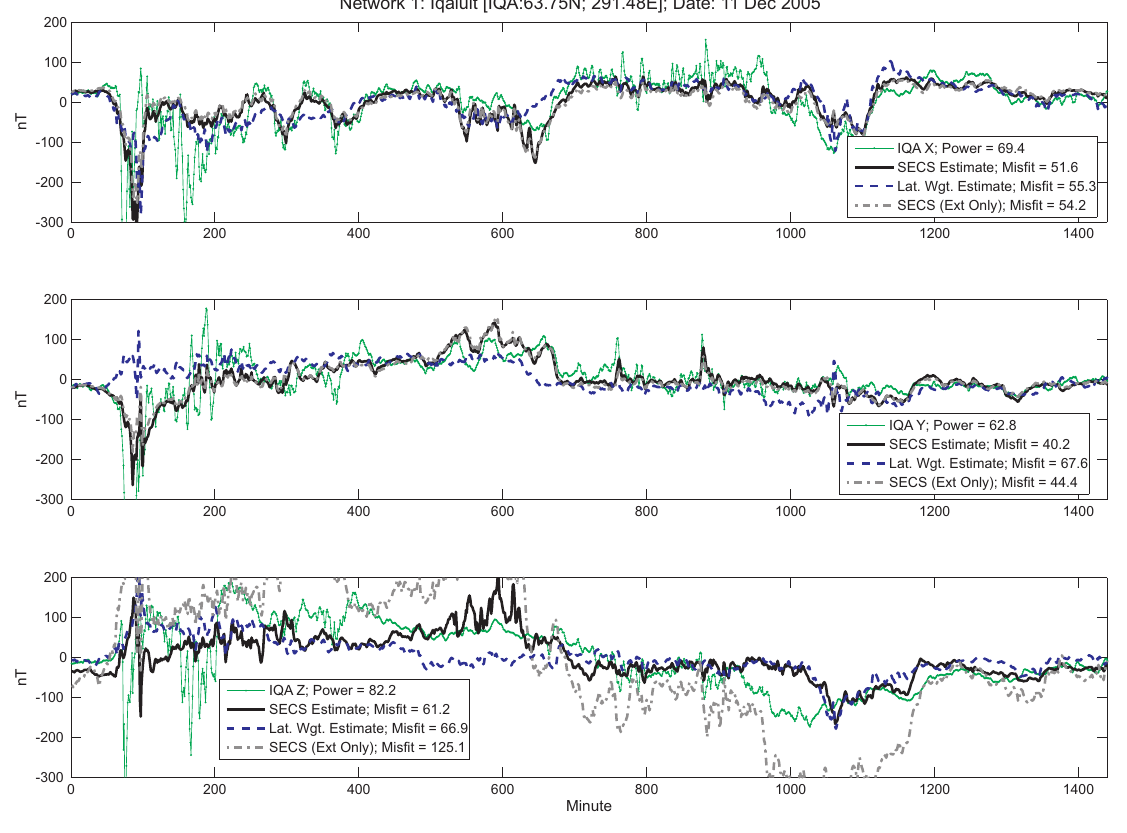
Fig. 2. Comparison of the measured external field disturbance (green solid, dots) and the estimate from SECS (black solid), Latitudinal Weighted (blue dashed) and SECS (External only) (grey dot-dash) at magnetic observatory Iqaluit (IQA) during a magnetically disturbed day (11 December 2005). Power and RMS misfit are in nT. Y-axis scaled to show finer